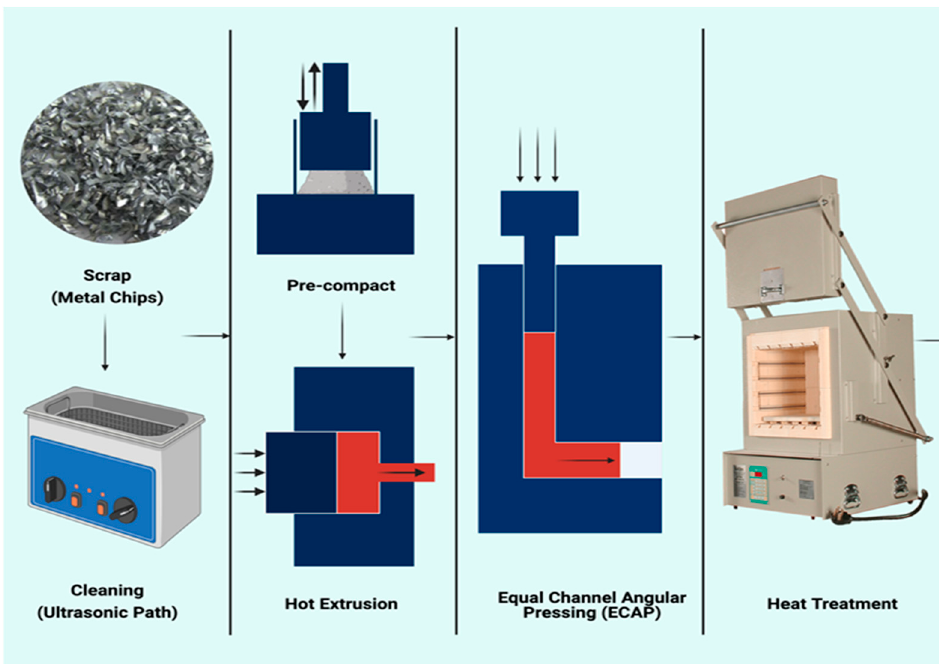
Figure 3. The sequence of the chip pre ‐ processing before and after consolidation [14].